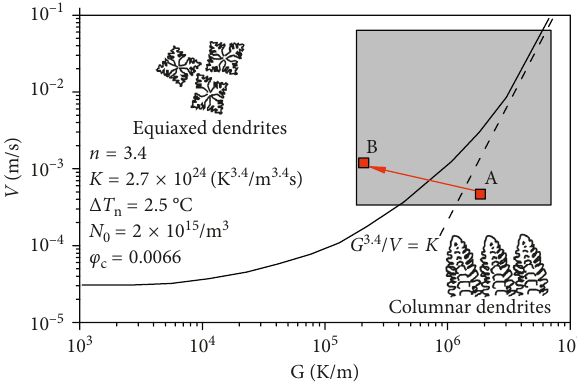
Figure 15: Microstructure selection map showing the expected solidification morphology as a function of G and V . The red arrow line shows the variation of conditions from the bottom of the melt pool (point A) to the top (point B), which is typical for the laser cladding. The parameter values were from the experimental results [26].